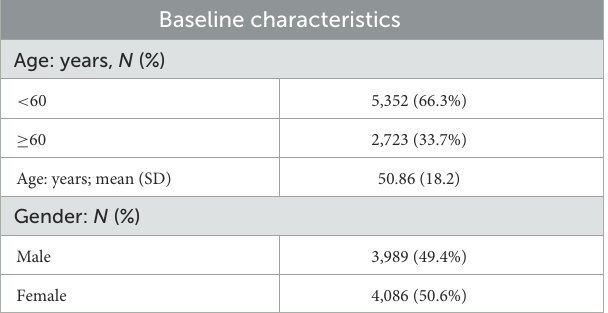
TABLE 2 Summarized statistical data of air pollutants and temperature. Baseline